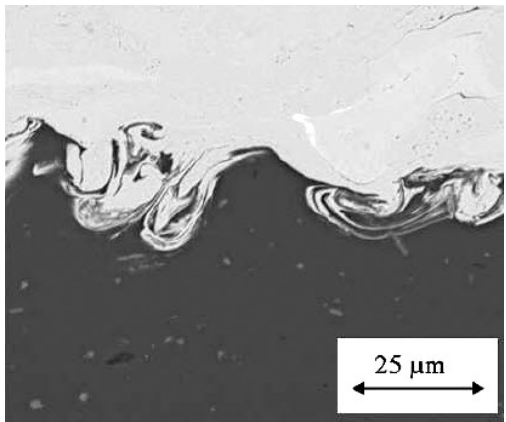
Figure 6. Energy dispersive spectroscopy image of a copper particle on an aluminum substrate [31]. Copyright 2005 Springer.